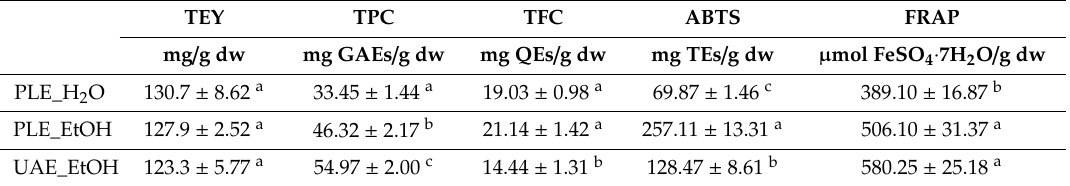
Table 2. Total extraction yield (TEY), total phenolic content (TPC), total flavonoid content (TFC), and antioxidant activity (ABTS and FRAP) of PLE and UAE spruce extracts with water (PLE_H 2 O) and absolute ethanol (PLE_EtOH and UAE_EtOH). TEY TPC TFC ABTS FRAP mg / g dw mg GAEs / g dw mg QEs / g dw mg TEs / g dw µ mol FeSO 4 · 7H 2 O / g dw PLE_H 2 O 130.7 ± 8.62 a 33.45 ± 1.44 a PLE_EtOH 127.9 ± 2.52